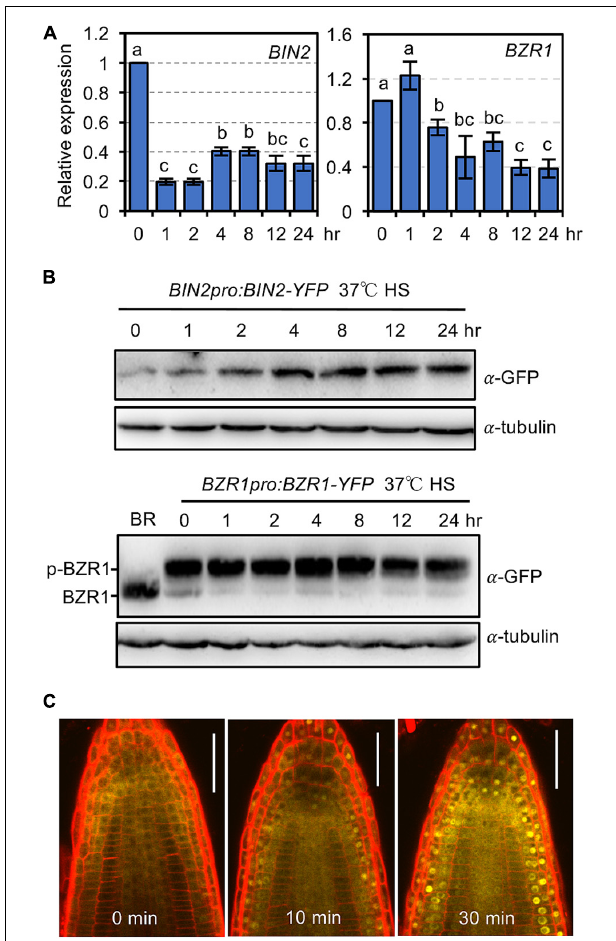
FIGURE 4 | Heat shock induces BIN2 protein accumulation and promotes the nuclear localization of BZR1. (A) The relative expression of BIN2 and BZR1 transcripts in 1-week-old Col-0 seedlings grown at 37 ◦ C for the indicated time. Error bars indicate the mean ± SD ( n = 3). Statistically significant differences are indicated by different lowercase letters ( p < 0.05, one-way ANOVA). (B) Immunoblotting revealed the abundance of BIN2-YFP and BZR1-YFP in 1-week-old seedlings treated at 37 ◦ C for the indicated time. For BR treatment, seedlings were soaked in ddH 2 O containing 1 µ M eBL for 2 h. (C) Confocal microscopic examination of the subcellular localization of BZR1-YFP in the roots of 5-day-old plants grown on 1/2 MS agar medium containing 0.5 µ M PCZ. The plates were treated at 37 ◦ C for the indicated time, and then the roots were mounted in a solution containing 0.5 µ M PCZ and 1 mg/mL of propidium iodide and observed. Scale bars, 20 µ